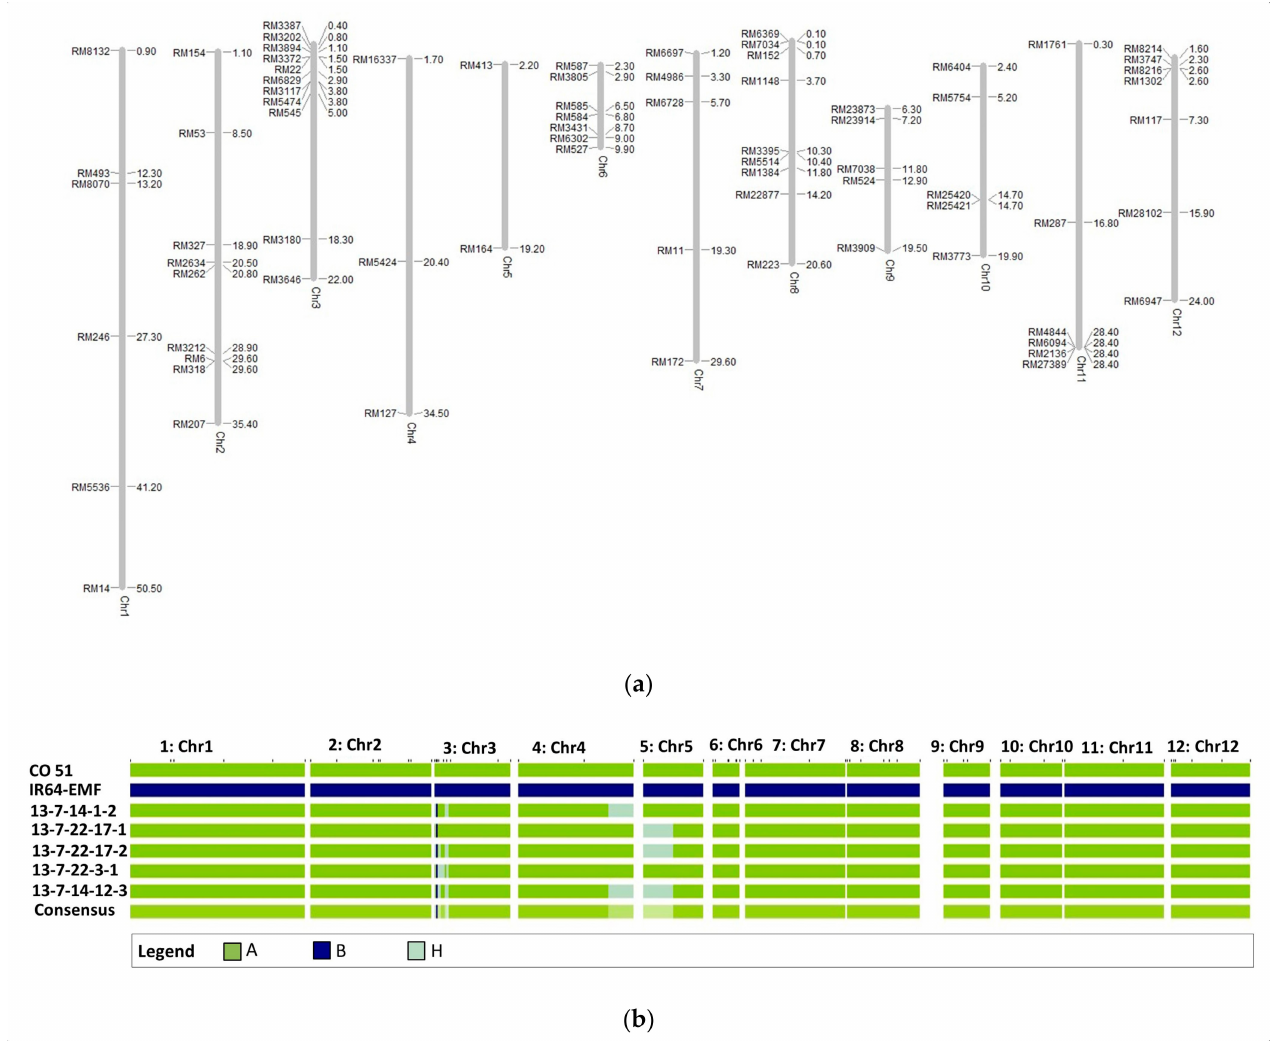
Figure 3. Foreground selection of the BC 3 F 2 progenies using RM3894 linked with the early morning flowering QTL (qEMF3) .